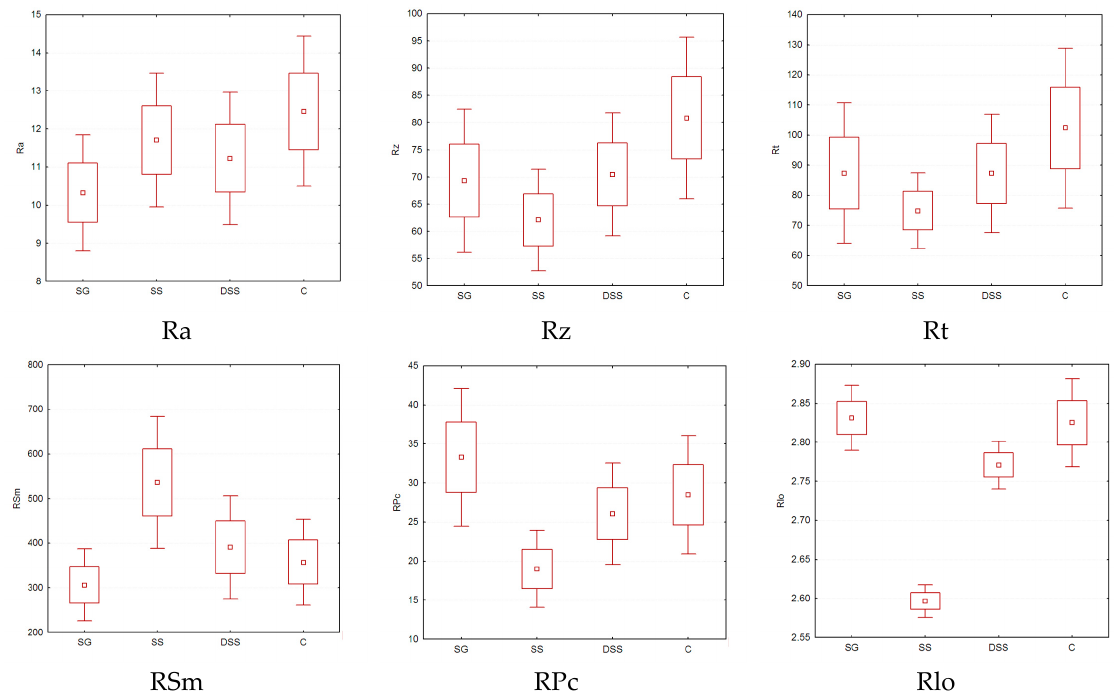
Figure 6. Boxplot (average and 1.96 standard deviation) for roughness parameters.